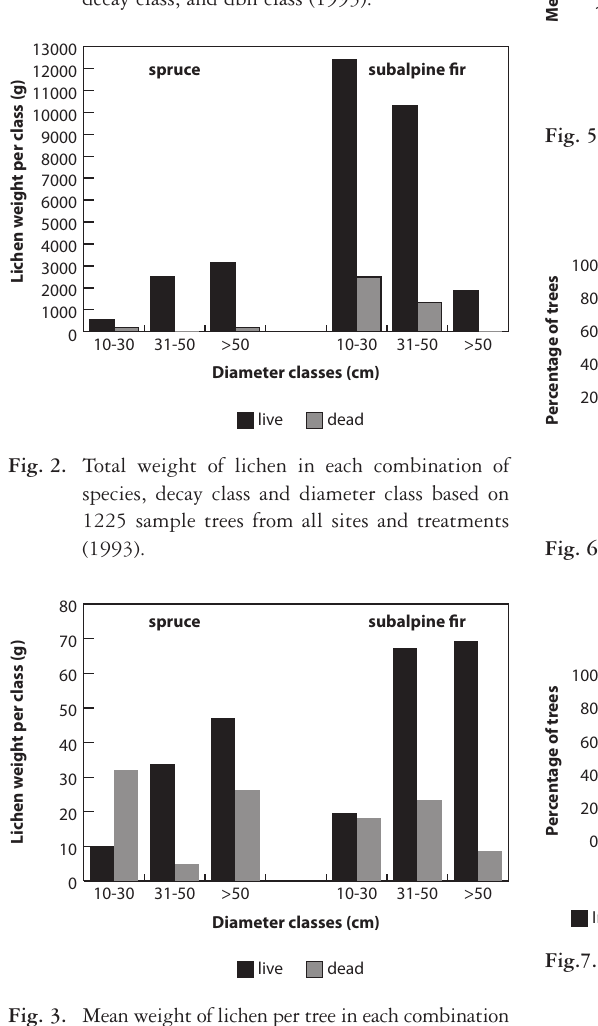
decay class, and dbh class (1993).